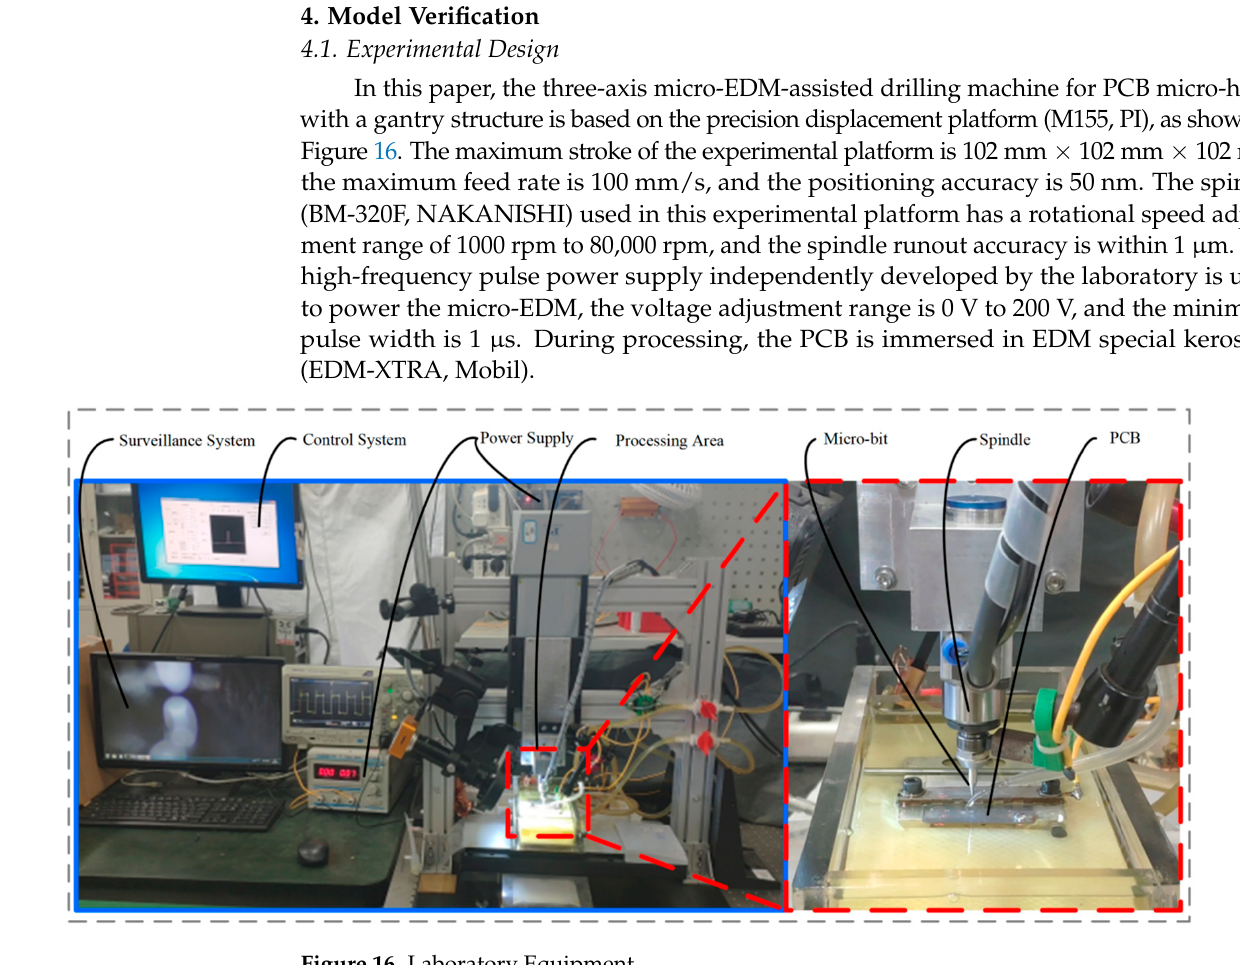
Figure 16. Laboratory Equipment.